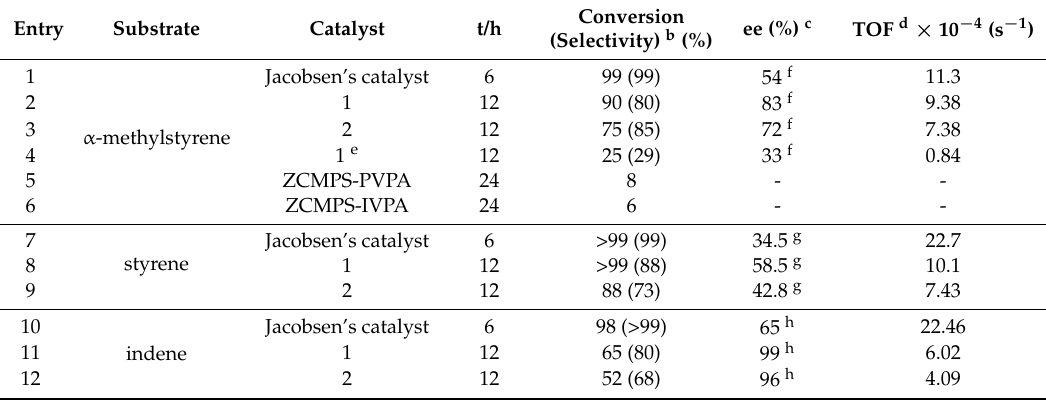
Table 2. Asymmetric epoxidation of different substrates by homogeneous and heterogeneous catalysts with NaClO as oxidant systems a .